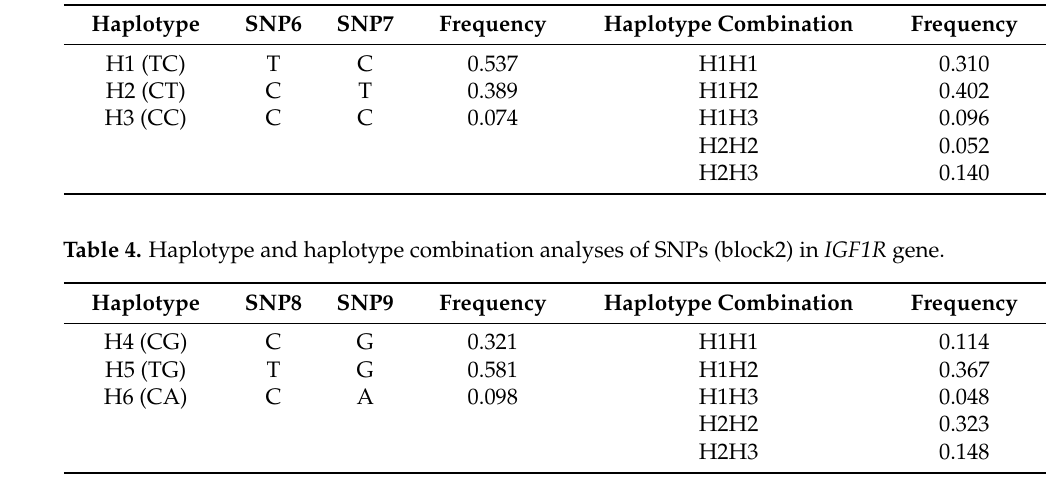
Figure 5. Linkage disequilibrium plot ( r 2 ) and haplotype blocks for SNPs of the IGF1R gene in Hulun Buir sheep. The values in boxes are pairwise SNP correlations ( r 2 ); dark red boxes indicate strong LD ( r 2 > 0.33) and light red boxes without numbers represent very weak LD ( r 2 < 0.001). Table 3. Haplotype and haplotype combination analyses of SNPs (block1) in IGF1R gene.